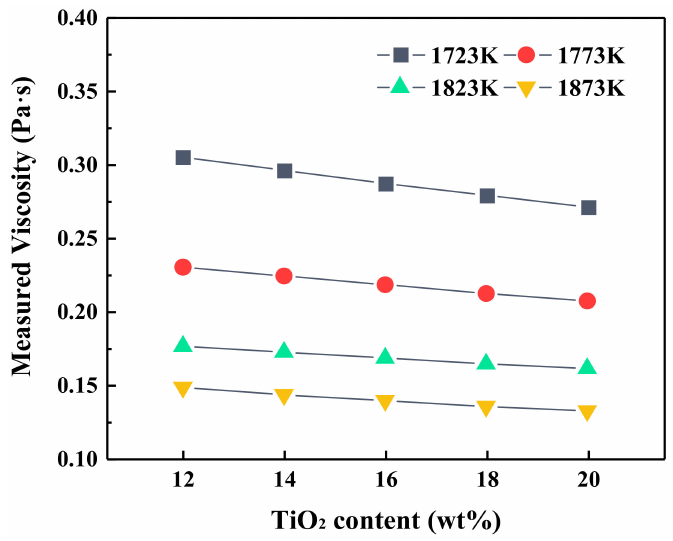
Figure 3. The viscosity of blast furnace (BF) slag with different TiO 2 contents.